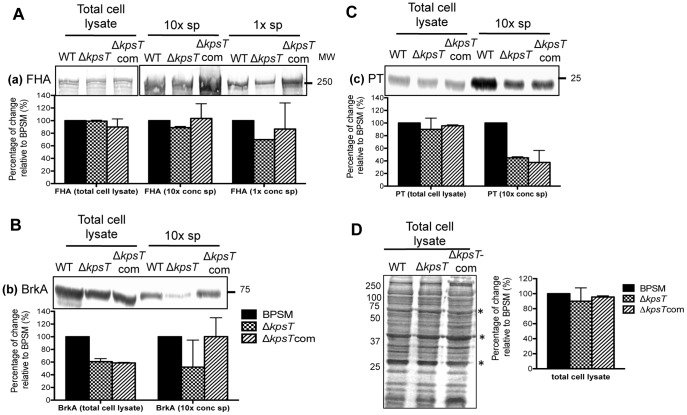
Production of bvg-regulated virulence proteins in ΔkpsT mutant.BPSM, ΔkpsT and ΔkpsTcom strains were exponentially grown in virulent Bvg+ phase. Western blot analysis was performed on 10x concentrated or non-concentrated culture supernatants, and whole cell extracts using (A) anti-FHA, (B) anti-BrkA or (C) anti-PT primary antibodies. Bars at the bottom of each blot represent protein densitometry quantification expressed as percentage of change relative to parental BPSM and was determined from two independent western blot sets. Molecular weights are indicated on the right side. (D) SDS-PAGE and Coomassie blue staining of BPSM, ΔkpsT and ΔkpsTcom whole cell lysate to estimate equal loading of protein content. Asterisks next to the Coomassie-stained bands indicate for loading control estimate. Bars represent protein densitometry quantification expressed as percentage of change relative to BPSM. Molecular weights are indicated on the left side.